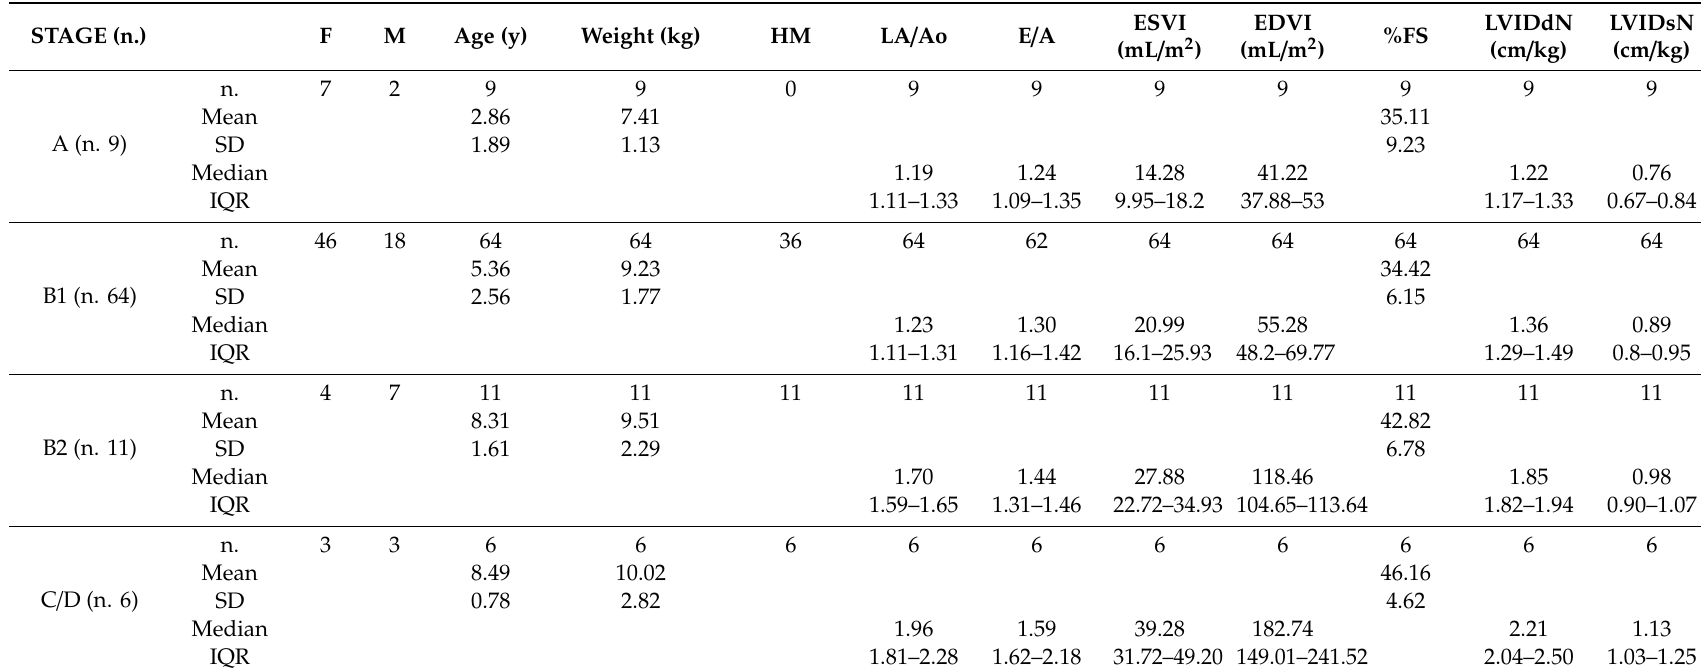
Table 1. Clinical and echocardiographic parameters of all included subjects related to ACVIM classes. Females (F); males (M); n. of subjects with heart murmur in each ACVIM class (HM); left atrium to aorta ratio (LA / Ao); E and A waves ratio (E / A); end-systolic volume index (ESVI); end-diastolic volume index (EDVI); shortening fraction (%FS); left ventricular internal diameter in diastole normalized for body weight (LVIDdN); left ventricular internal diameter in systole normalized for body weight (LVIDsN). The variables are reported as the mean and standard deviation (SD) in cases of normal distribution, and otherwise as the median and interquartile ranges (IQR—from 25th to